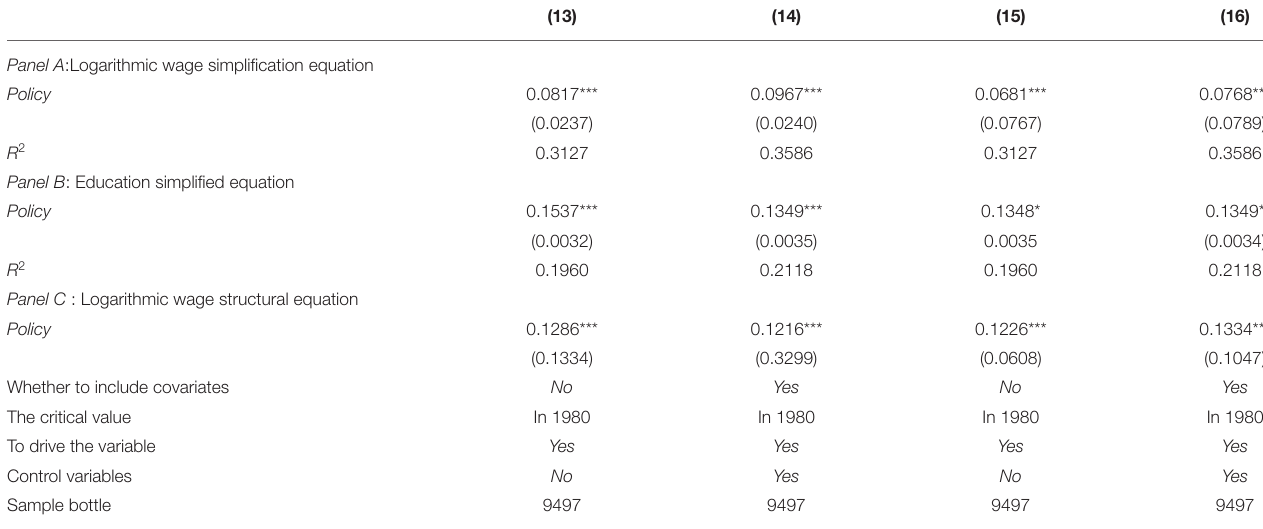
TABLE 6 | Fuzzy RDD estimation results.